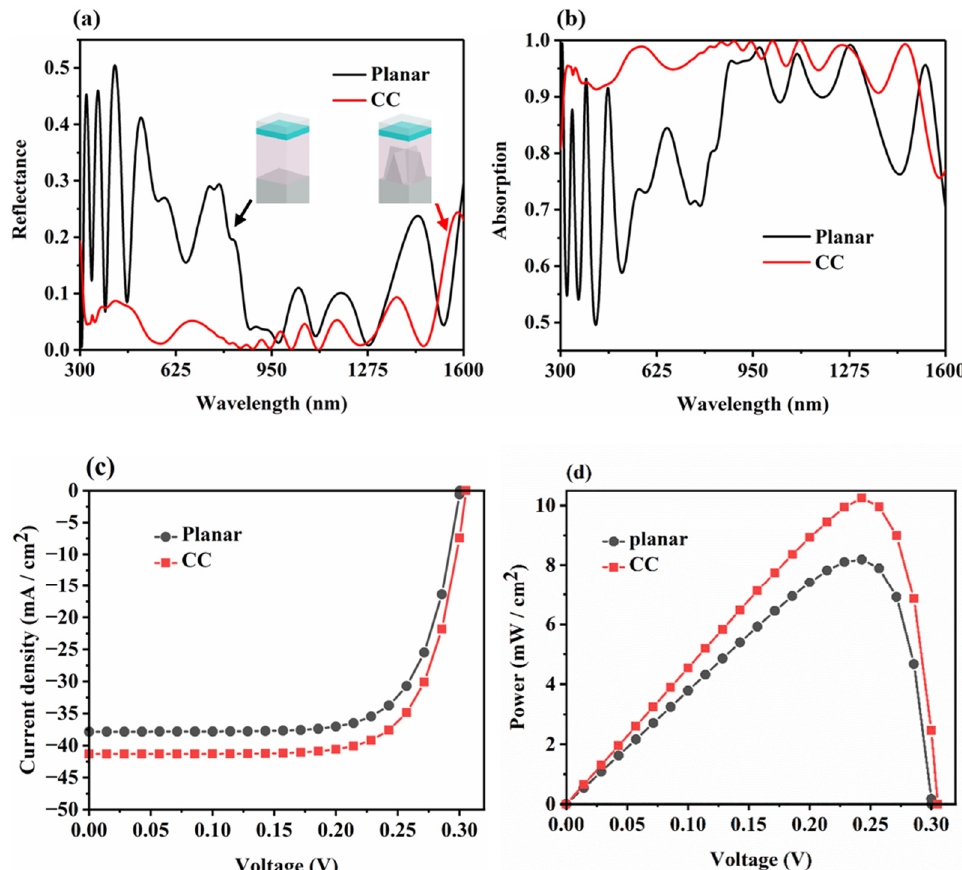
Figure 7. ( a ) The influence of the presence or absence of the CC nanostructure on the reflectivity. ( b ) The effect of the presence or absence of the CC nanostructure on the absorptivity. ( c ) The influence of the presence or absence of the CC nanostructure on the current density. ( d ) The influence of the presence or absence of the CC nanostructure on the output power. Table 1. Comparison of performance of different Ge micro ‐ nanostructured solar cells.